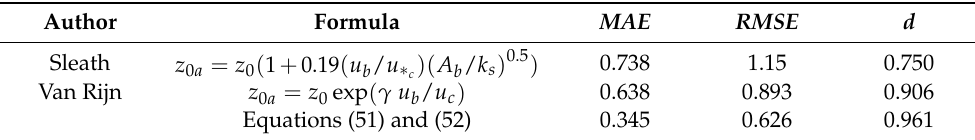
Table 3. Comparison between calculated and experimental z 0 a of different